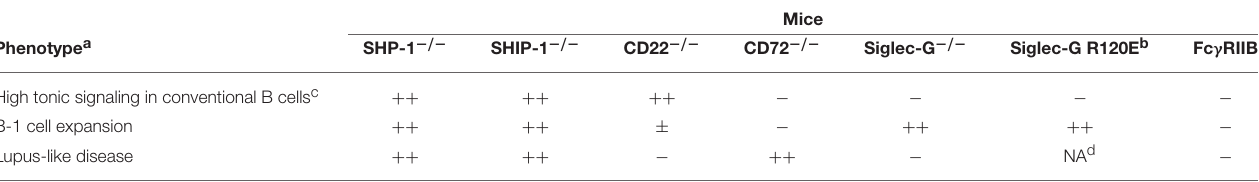
TABLE 1 | B cell phenotypes of mice deficient in inhibitory B cell co-receptors, ligands, and effector phosphatases.